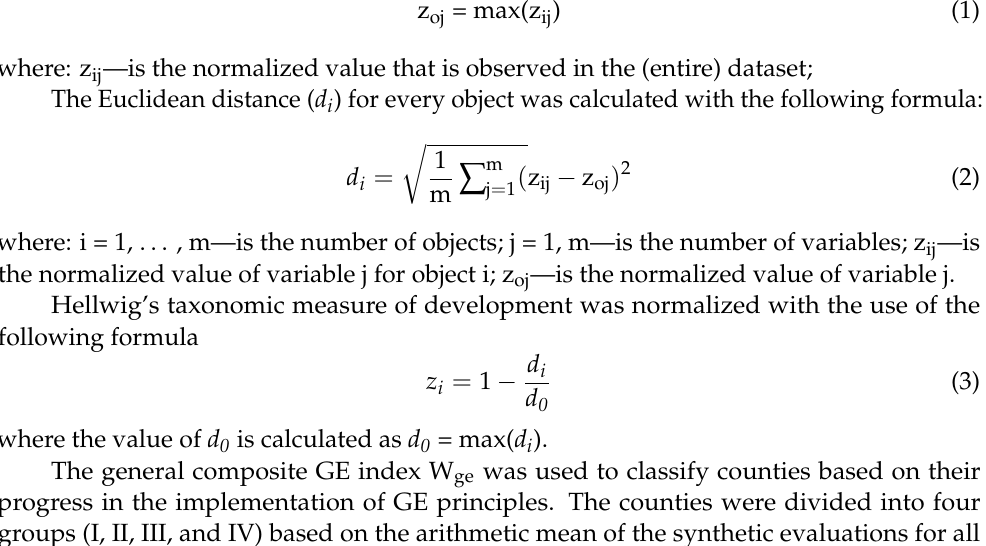
Table 3. Division of counties into classes based on the applied classification criteria. Class Classification Criterion Evaluation I Rav-s > Ri low Rav > Ri > Rav–s medium low Rav + s > Ri > Rav Ri > Rav + s